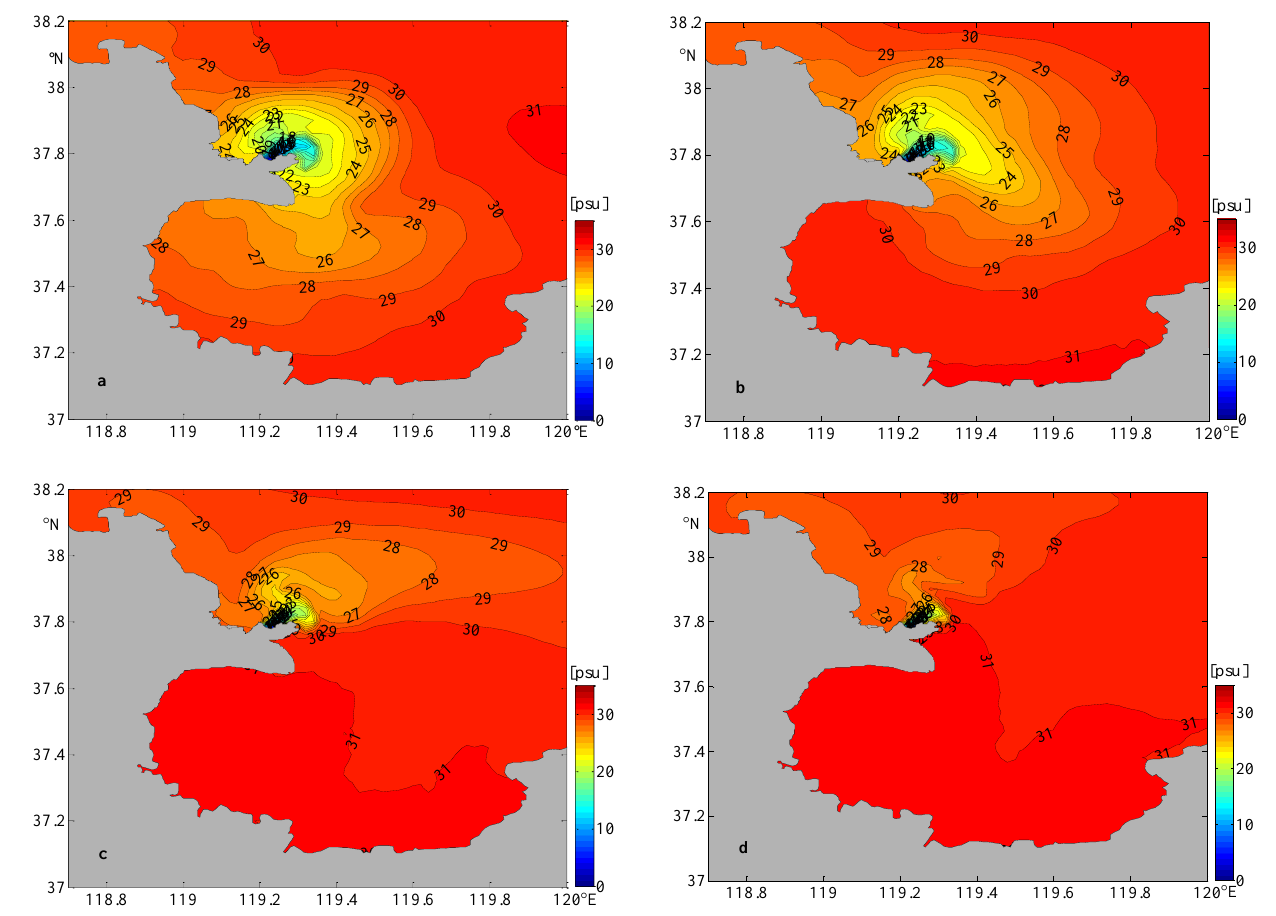
Figure 13. Surface salinity distribution at different wind speeds in the wet season. (( a ): case 3, ( b ): case 4, ( c ): case 5, ( d ): case 6). Figure 14 shows the vertical salinity diffusion in the range of 37.7° N–38.6° N at the section of 119.25° E. When the wind speed was low (case 3 and case 4), there were more horizontal layers of salinity, and low salinity water diffused a longer distance. Figure 15 shows the statistical diagram of surface area of 27 psu isohaline in the wet and dry seasons under different wind speeds. When the wind speed increased, the surface area of low- salinity water became smaller and smaller. When the wind speed was over 4 m/s, the area